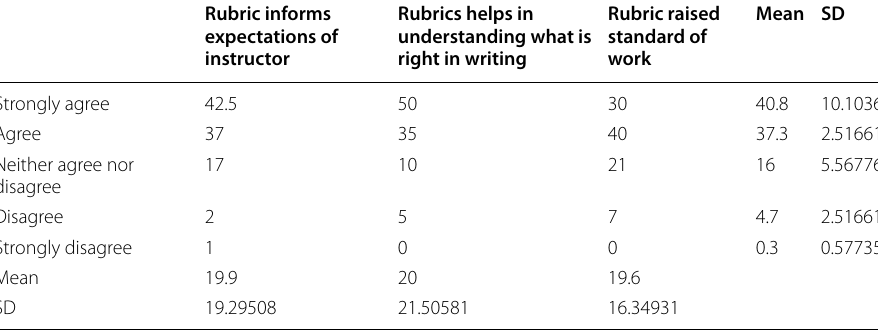
Table 1 Descriptive Statistics